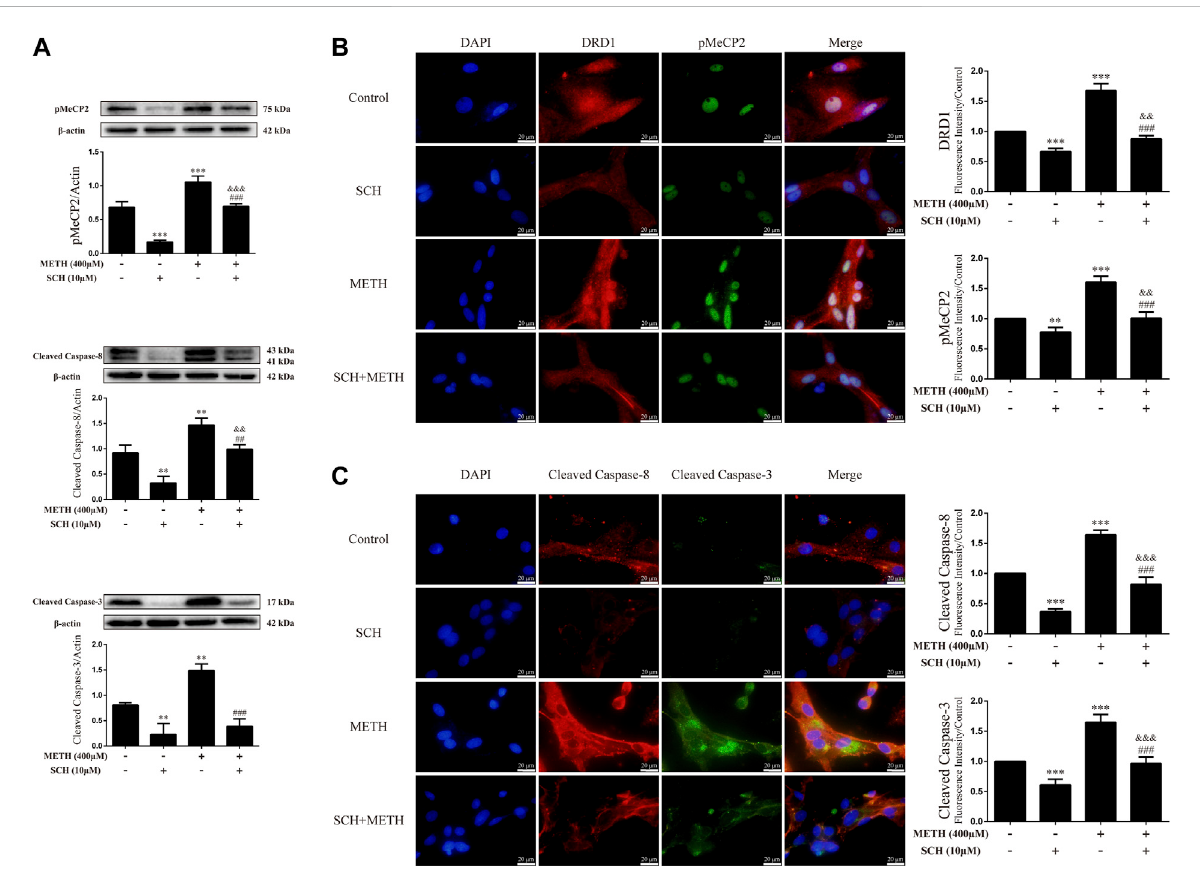
FIGURE 5 Protein levels and colocalization in neurons incubated with SCH23390 and/or METH. (A) Levels of pMeCP2 and apoptosis-related proteins. (B) DRD1 and pMeCP2 levels and their colocalization. (C) Cleaved caspase-8 and cleaved caspase-3 levels and their colocalization. ** p < 0.01 or *** p < 0.001 compared with control group, ## p < 0.01 or ### p < 0.001 compared with METH group, && p < 0.01 or &&& p < 0.001 compared with SCH23390 group; Tukey HSD post-hoc comparison after signi fi cant